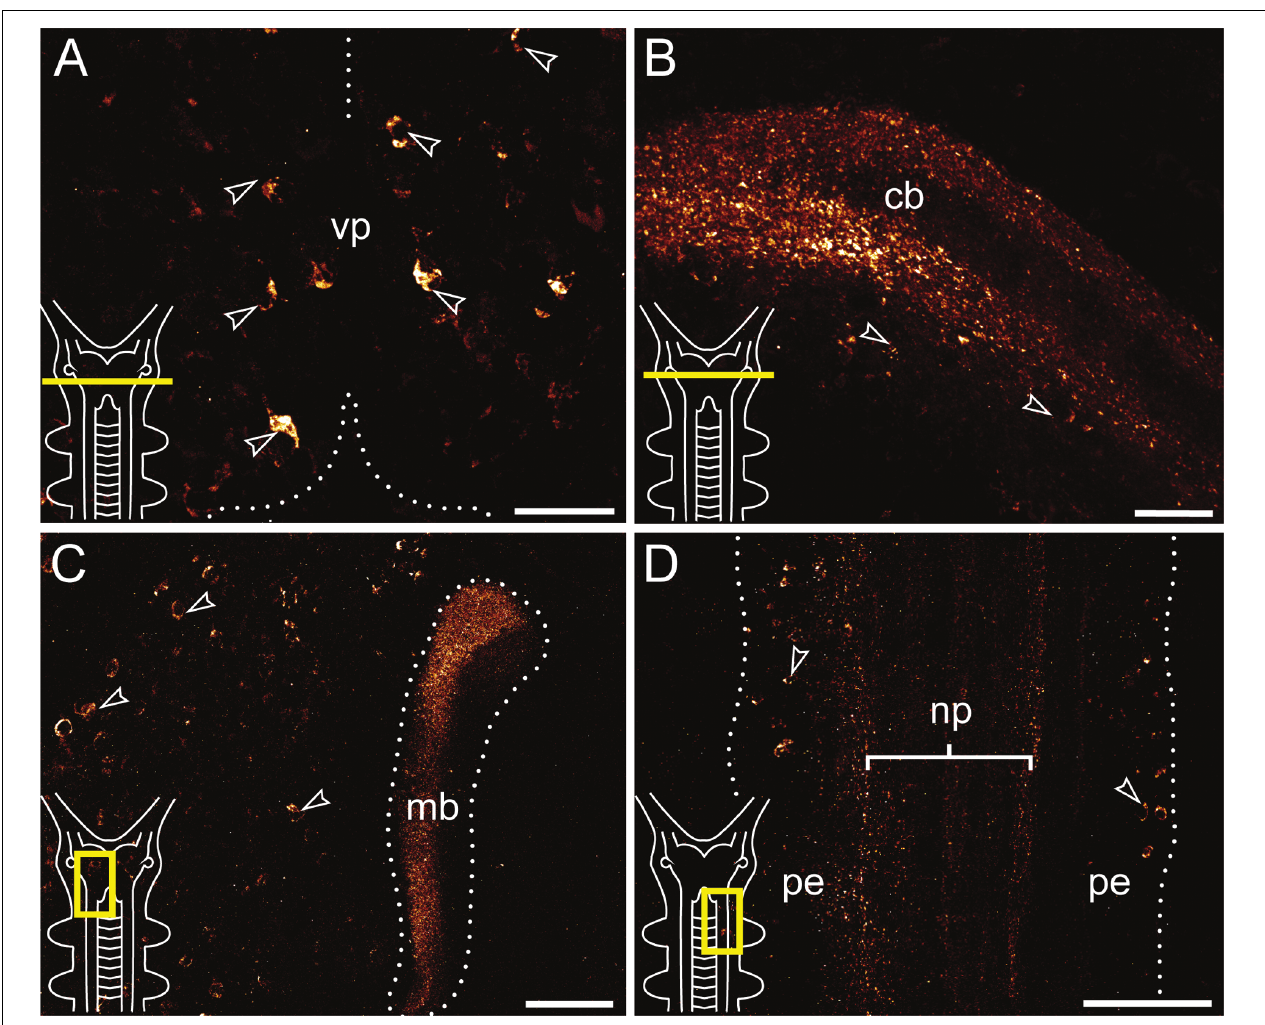
FIGURE 3 | Immunolocalization of arthropsin in the nervous system of the onychophoran Euperipatoides rowelli Vibratome sections. Confocal micrographs. Insets in the lower left corners illustrate sectional planes (yellow bars). (A) Cross section of the ventral portion of the brain. Dorsal is up. Note the ventral group of somata in the protocerebrum (arrowheads). (B) Cross section of the central body. Dorsal is up. Note the outer and inner fiber layers and the associated immunoreactive somata (arrowheads). (C) Horizontal section of the mushroom body. Anterior is up, median is left. Note prominent immunoreactivity in the inner lobe of the mushroom body and numerous immunoreactive somata in the medioventral region of the protocerebrum (arrowheads). (D) Horizontal section of the ventral nerve cord. Anterior is up, median is left. Note immunoreactive fiber bundles within the nerve cord neuropil with associated somata in the perikaryal layer (arrowheads). Abbreviations: cb, central body; mb, mushroom body; np, nerve chord neuropil; pe, perikaryal layer; vp, ventral protocerebrum. Scale bars: 25 µ m (A,B) , 50 µ m (C) , 100 µ m (D)